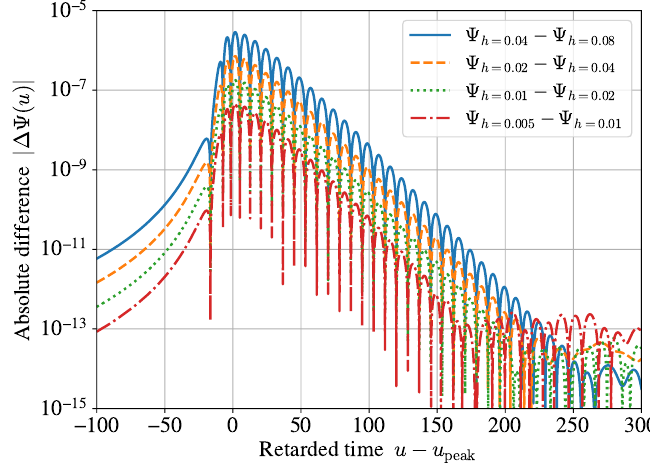
Figure 2. Absolute differences between the results with different resolutions, h / M = ( 0.08, 0.04, 0.02, 0.01, 0.005 ) . For example, Ψ h = 0.04 − Ψ h = 0.08 (the blue solid curve) denotes the absolute differ- ences between ( (cid:96) = 2, m = 0 ) mode of the Zerilli-Moncrief function for case A in the h / M = 0.08 and 0.04 simulations. The plot demonstrates the second order convergence of our time domain code. The numerical accuracy with the highest resolution is roughly estimated as 10 − 7 at the time of the peak amplitude u peak , and 10 − 13 in the late time of ( u − u peak ) / M (cid:38)